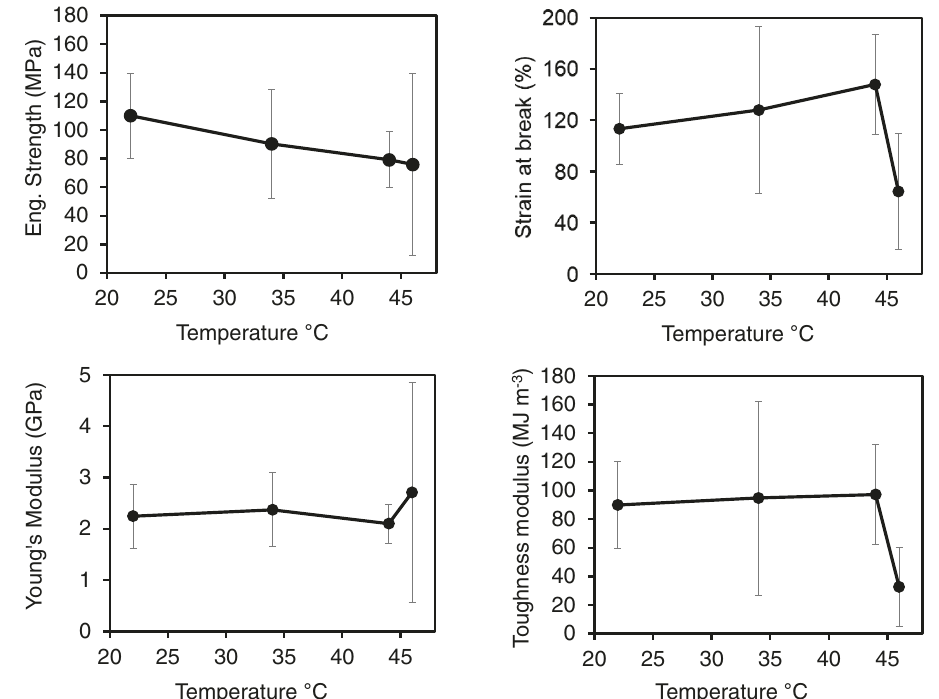
Fig. 8 Tensile properties of NT2RepCT fi bers as a function of the temperature of the spinning buffer. All fi bers were collected at a reeling speed of 58 cm/s. The reference fi bers at 22 °C is the grand average of all fi bers spun at 58 cm/s, as shown in Fig. 6. Each data points represents the average of n ≥ 10 measurements, with error bars ±one standard deviation. The corresponding stress-strain curves are shown in Supplementary Fig. 18. Other parameters relevant for this spinning experiment are found in Supplementary Table 2.